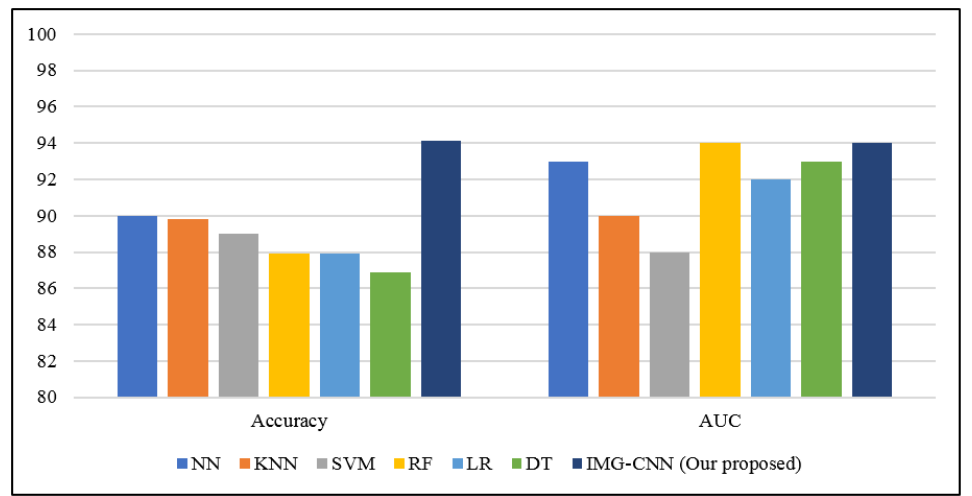
Figure 15. Comparison of the performance evaluation metrics of the different models presented in previous studies (NN, KNN, SVM, RF, LR, and DT) and our proposed IMG-CNN model using the same clinical dataset.